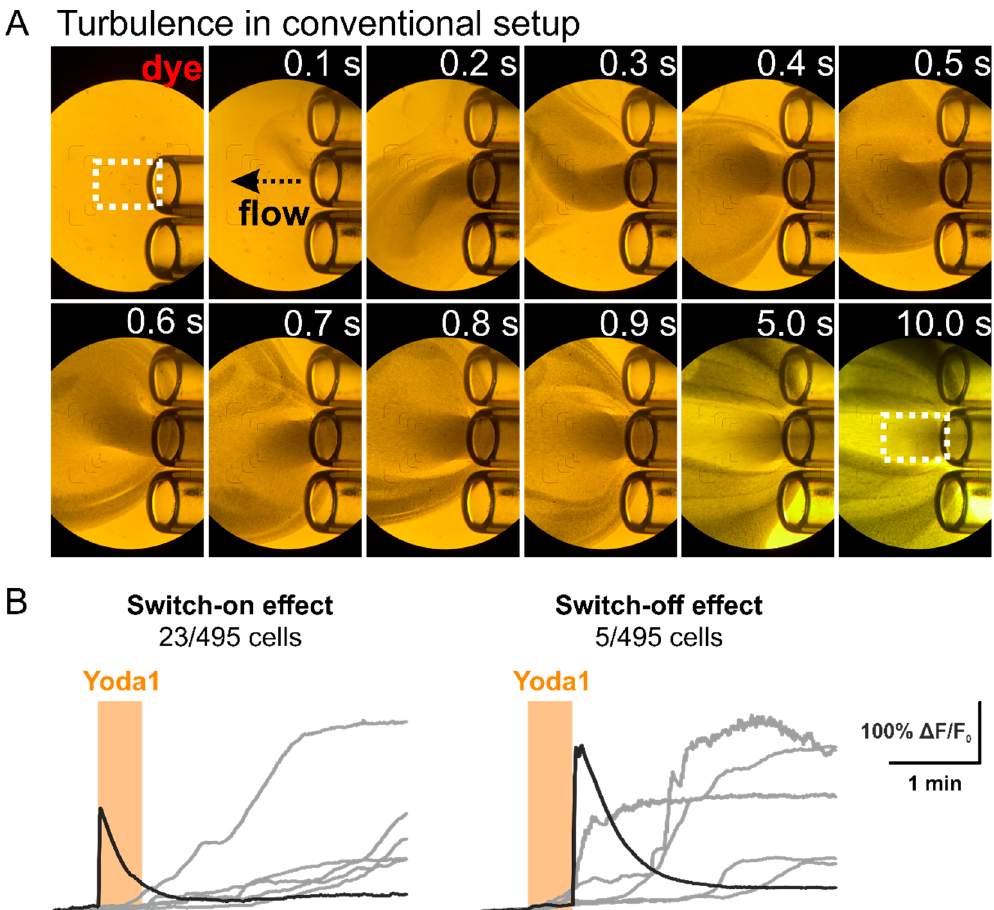
Figure 3. Turbulence occurring in conventional imaging setup. ( A ) Subsequent frames depict application of dye through fast application system. Tube switching causes substantial turbulence (0.2–0.6 s) that may underlie appearance of an atypical Yoda1 calcium transient. Black arrow indicates flow direction. ( B ) The sharp transients (black) different from normal Yoda1 responses (grey), seen in 5% of the cells (23/495) in the beginning of the application and in 1% of the cells (5/495) in the end of the application are likely associated with this non-intentional shear stress. White dashed rectangles mark target imaging region.